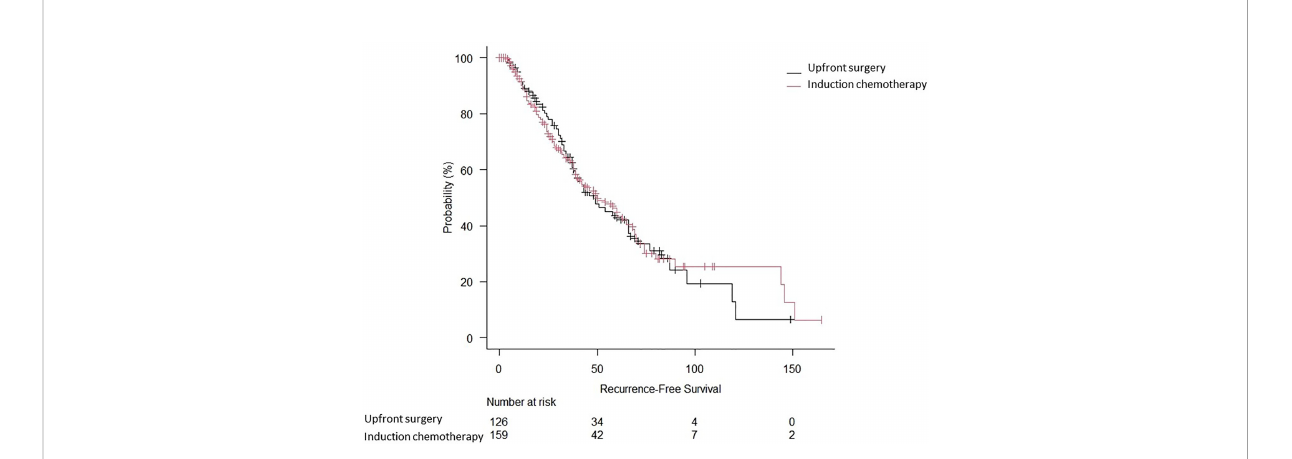
FIGURE 3 Recurrence-free survival of biopsy-proven N2 NSCLC patients who underwent upfront surgery or induction